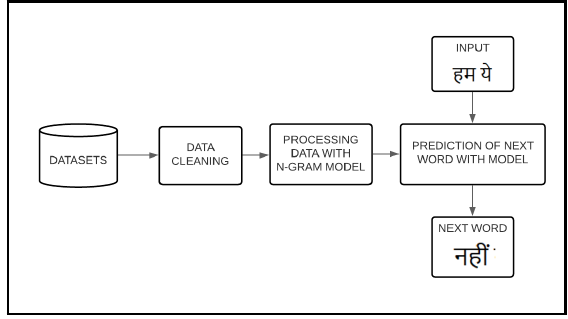
Fig 4.1 Process flow of